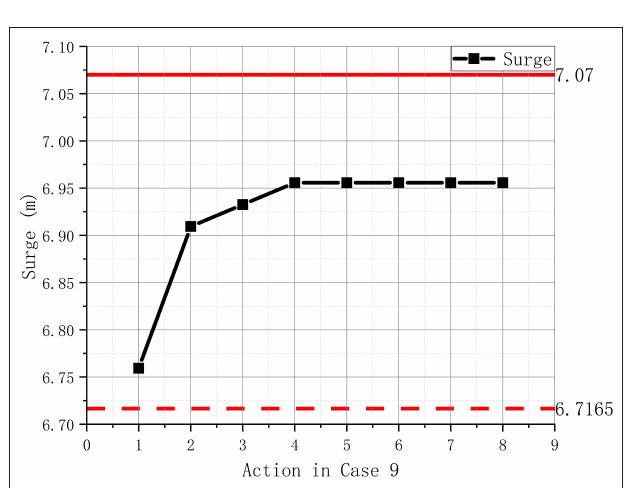
FIGURE 5 | Average surge amplitude change in case